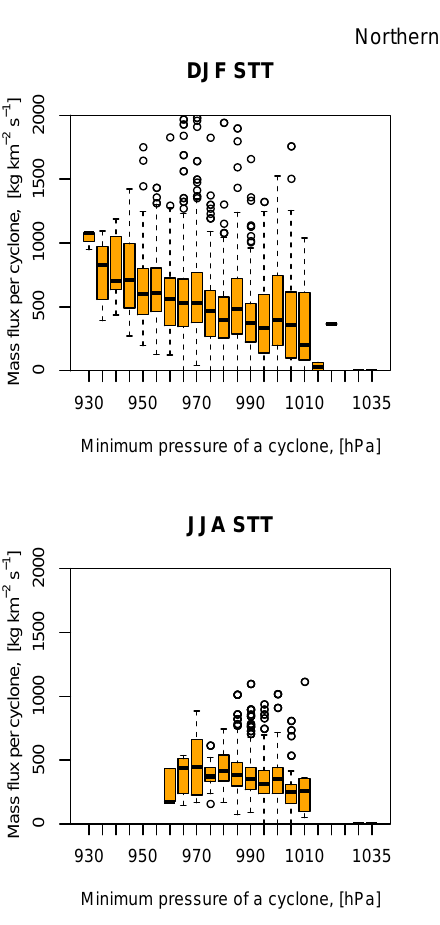
phase. Additionally, for each phase of the life cycle the mass flux for STT and TST is shown.